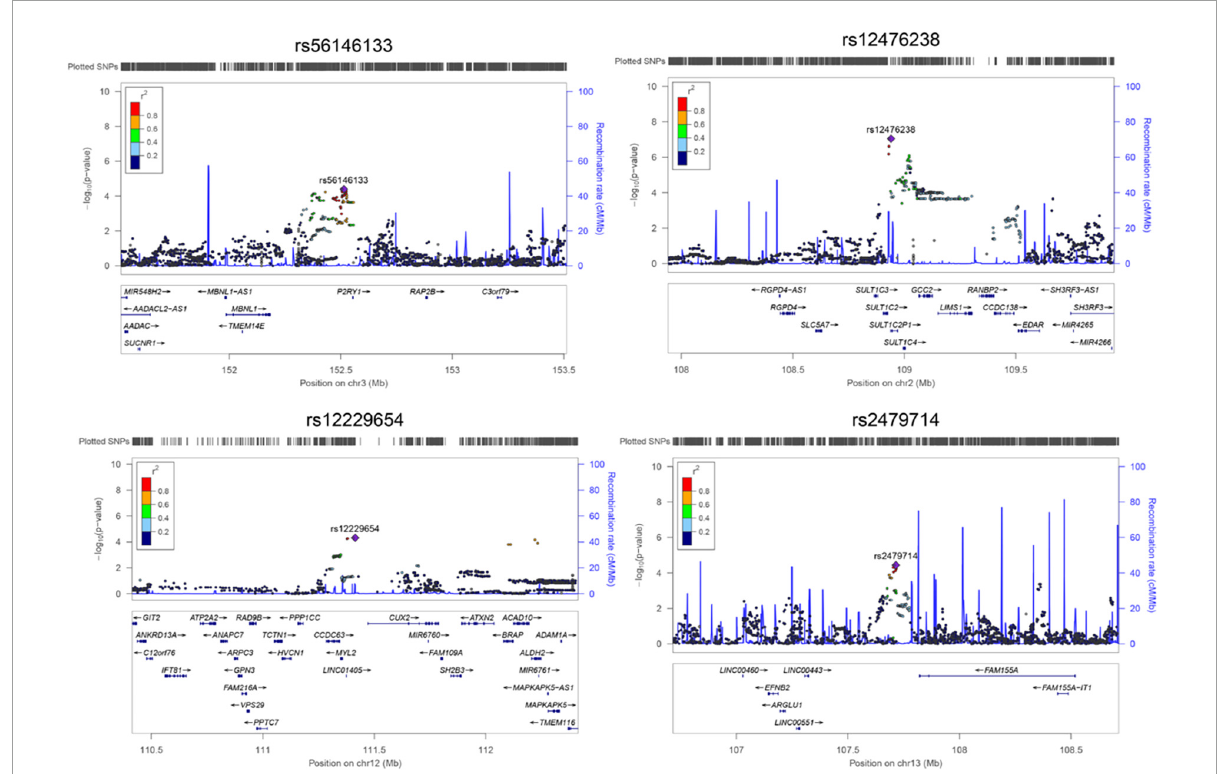
FIGURE3 The regional plot for associations between four single nucleotide polymorphisms (SNPs) and Gamma-glutamyl-leucine (Gamma-Glu-Leu) levels ( N = 1,062). Single nucleotide polymorphism position was based on hg19. Regional plot was drawn using Locuszoom based on the Asian population of the 1000 Genome